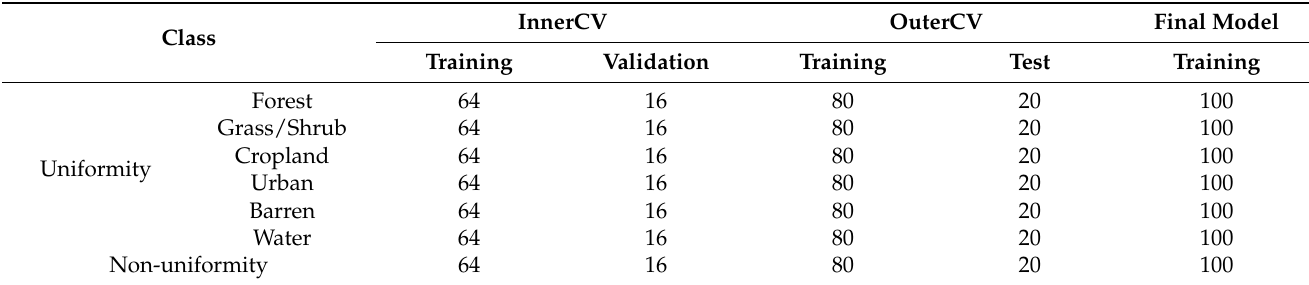
Table 3. Number of training, validation, and test data for nested